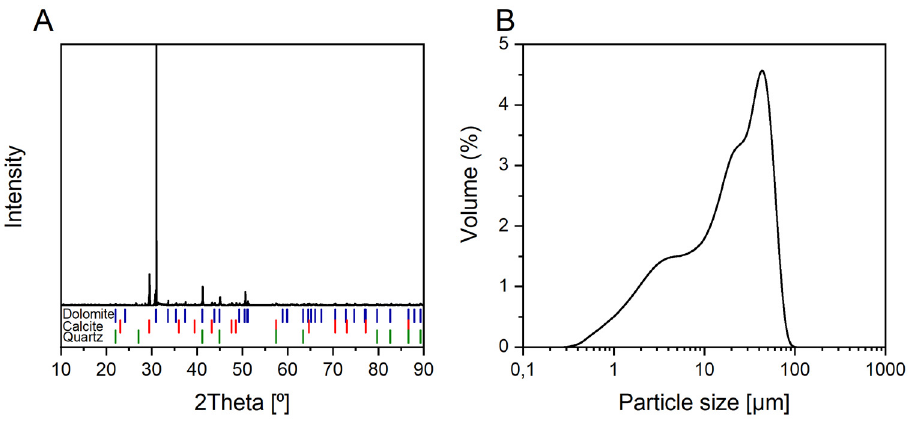
Figure 9. XRD pattern ( A ) and particle size distribution ( B ) of Kletno dolomite sample. Table 4. Physical properties of dolomite sample. S BET —specific surface area; d 10,50,90— deciles of size